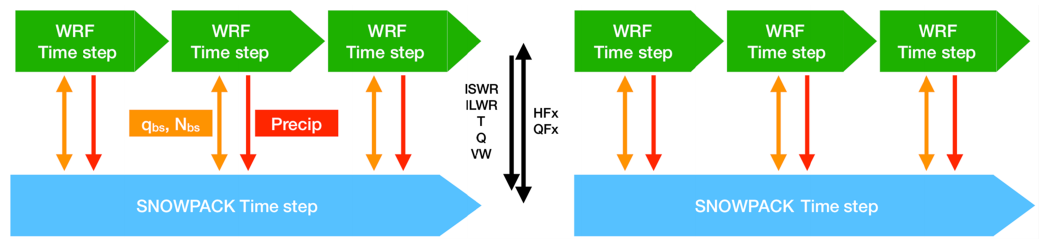
Figure 2. Flexible time-stepping of SNOWPACK within CRYOWRF. SNOWPACK can be called at any integer multiple of WRF’s time step. In this schematic, SNOWPACK is called every three WRF time steps. The orange (blowing snow) and red (precipitation) arrows indicate fast exchange of mass between the snowpack and WRF. At intervals of (cid:49)t SN , slow dynamics for thermal processes are accounted for by solving the heat equation in the snowpack.